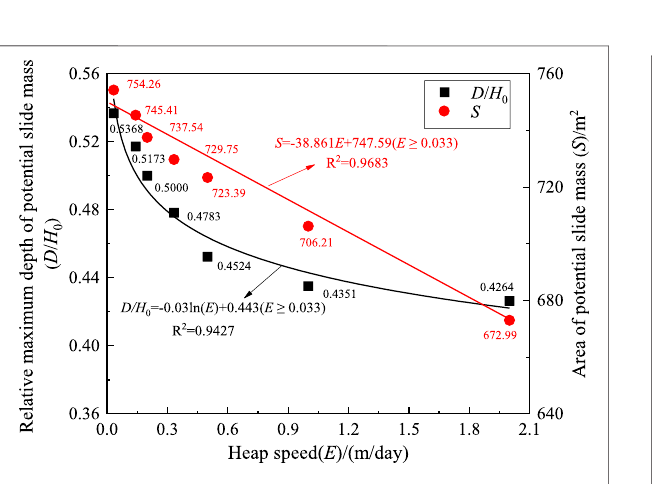
FIGURE 9 | Variations of relative maximum depth and area of potential slide mass with heap speed at T = 2.0 m.